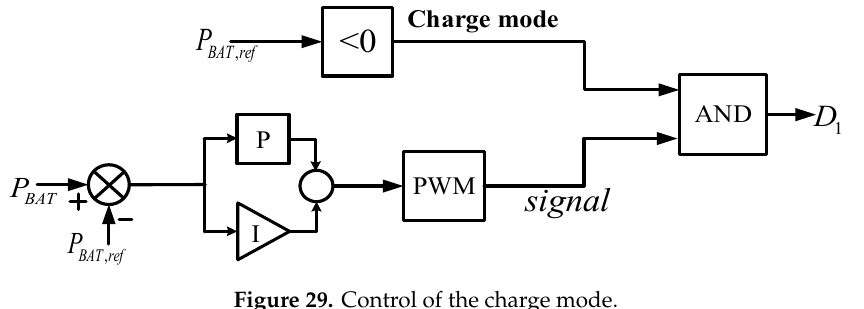
Figure 29. Control of the charge mode.